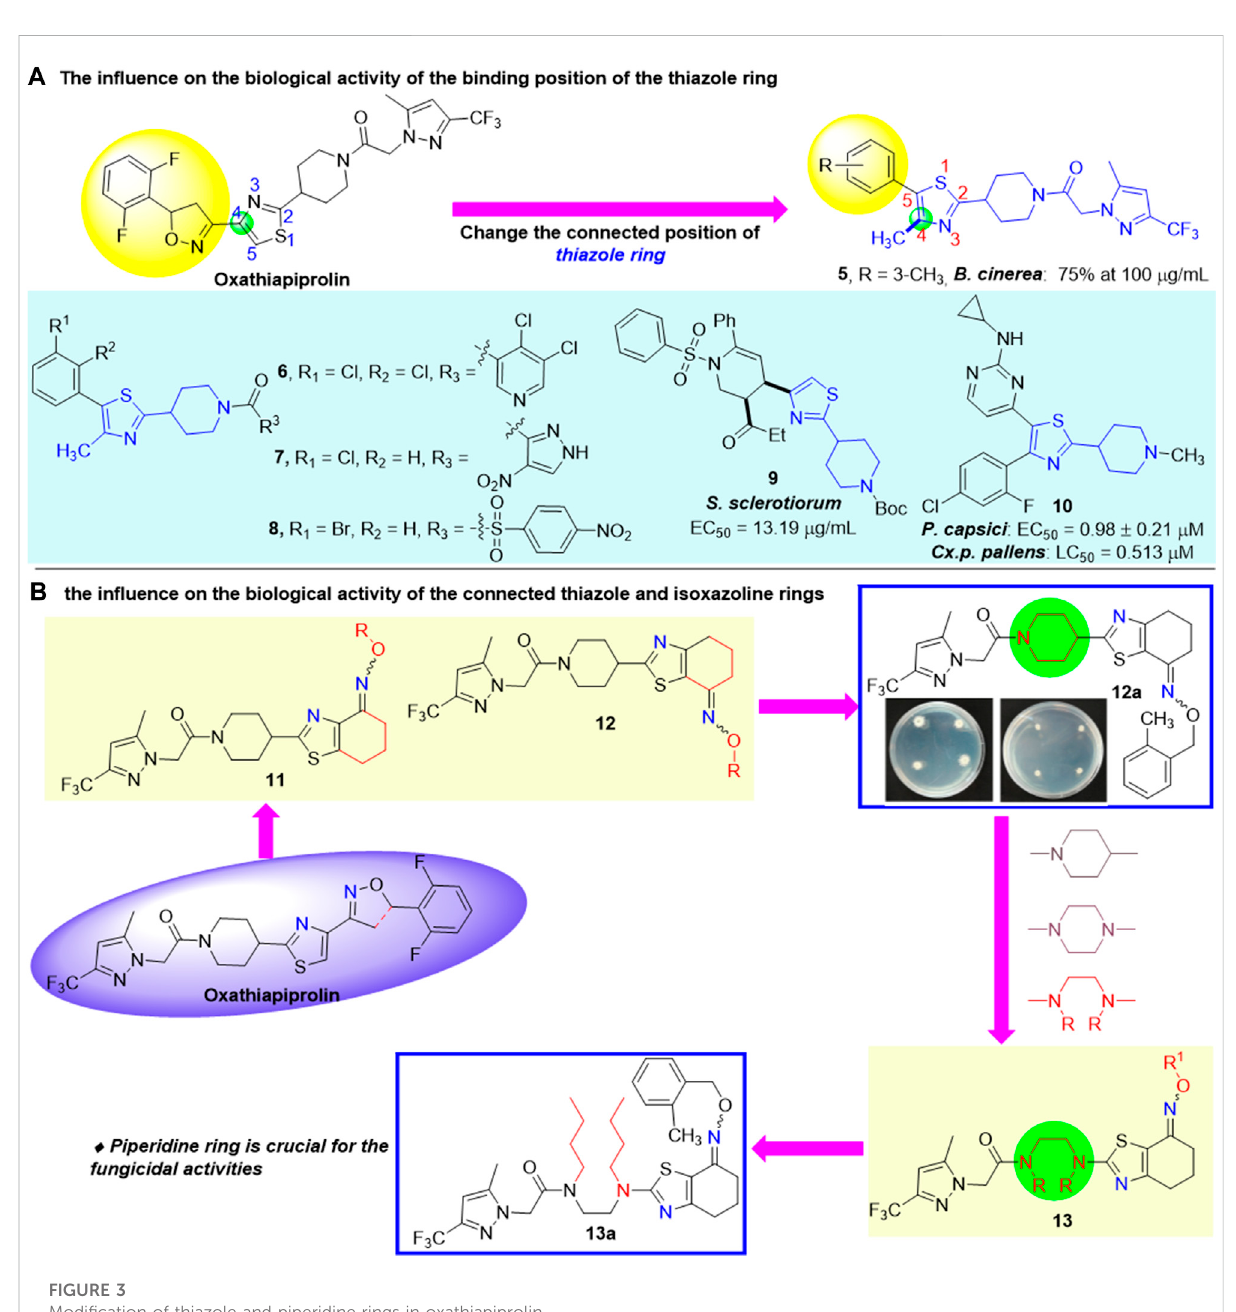
FIGURE 3 Modi fi cation of thiazole and piperidine rings in